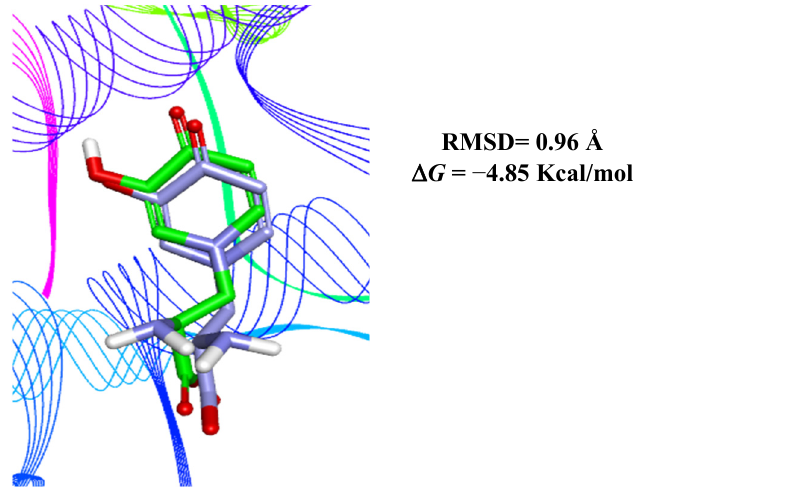
Figure 8. Superimposition of the docked MMS positive control (green) with the corresponding pose of the co-crystallized ligand in the enzymatic site of human tyrosinase (Lilac). Validation of the in silico model, as proposed in this study, was considered